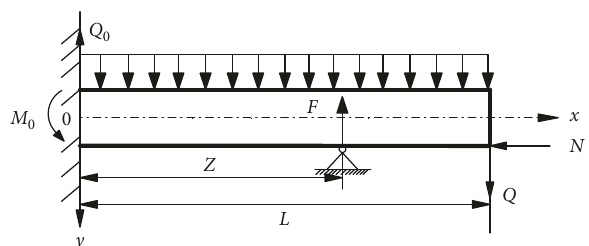
Figure 7: Mechanical model of main roof suspension above coal pillar after mining